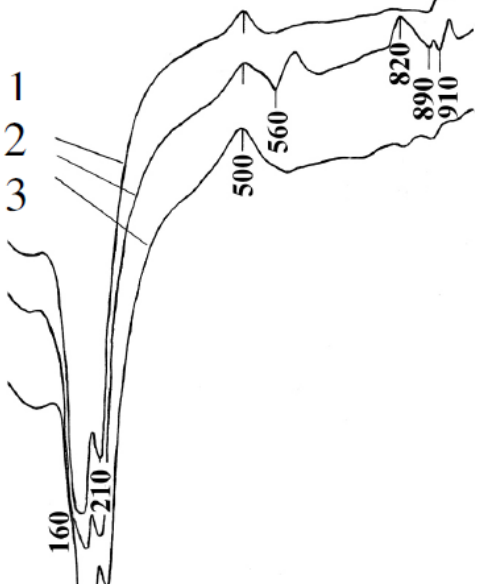
Figure 7. XRD patterns of the GCB-FA ( 1 ) and GCB-S ( 2 ); a— comparison of the profiles of the main interplanar distances of alite and belite in the GCB-FA (I) and GCB-S (II). The XRD pattern contains peaks of two strong varieties of silicates (albite and anorthoclase K, Na (AlSi 3 O 8 ) (d = 3.888, 3.283, 3.23, 2.983 A).